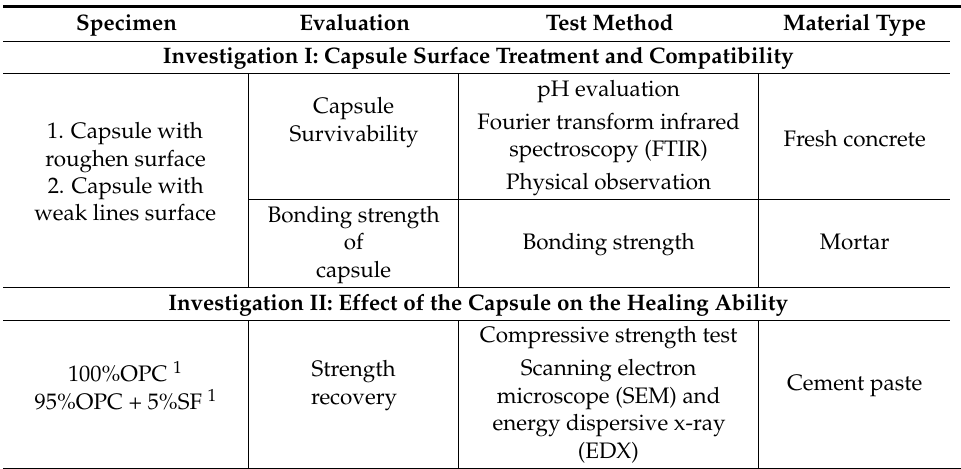
Table 2. Summary of the key investigation regarding the scope of research